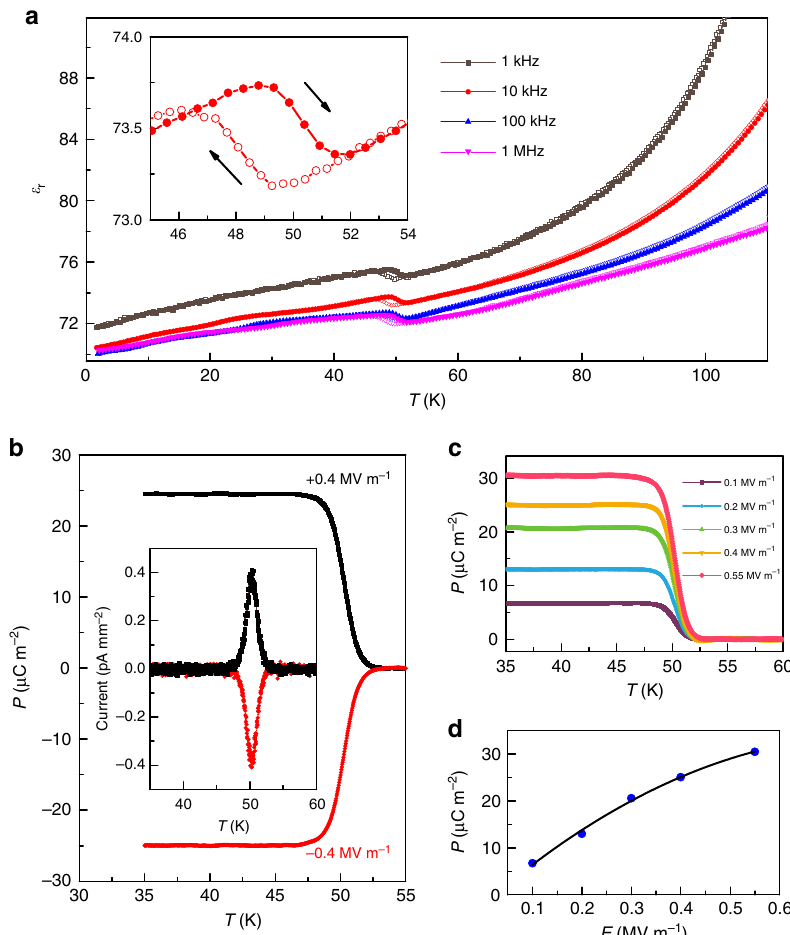
Fig. 5 Spin-induced ferroelectricity in the binary perovskite Mn 2 O 3 . a The dielectric constant as a function of temperature. A dielectric peak with a hysteresis is seen at T 2 = 49 K, indicating a fi rst-order ferroelectric transition. No apparent dielectric anomaly at T 1 = 101 K is detected. The inset shows an enlarged view around T 2 . b The electric polarization as a function of temperature measured with a poling electric fi eld of 0.4 MVm − 1 . The polarization is reversed by a negative poling fi eld. The inset presents the pyroelectric current as a function of temperature after subtracting the background. The peak around T 2 con fi rms spin-induced ferroelectricity. c The electric polarization measured with different poling electric fi eld. d The electric polarization as a function of poling electric fi